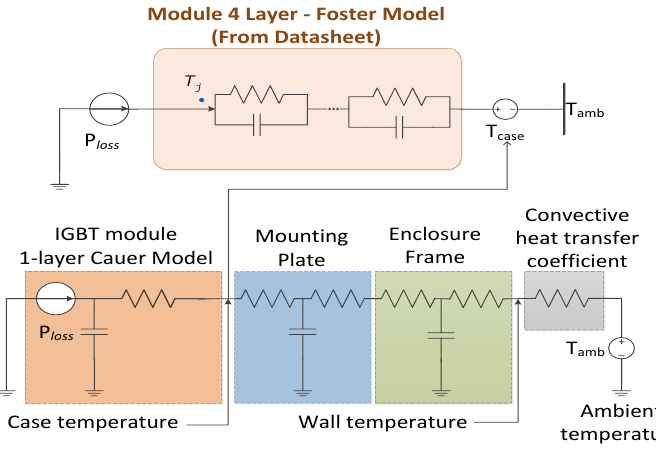
Figure 14. Lumped element thermal network model for the system shown in Figure 2